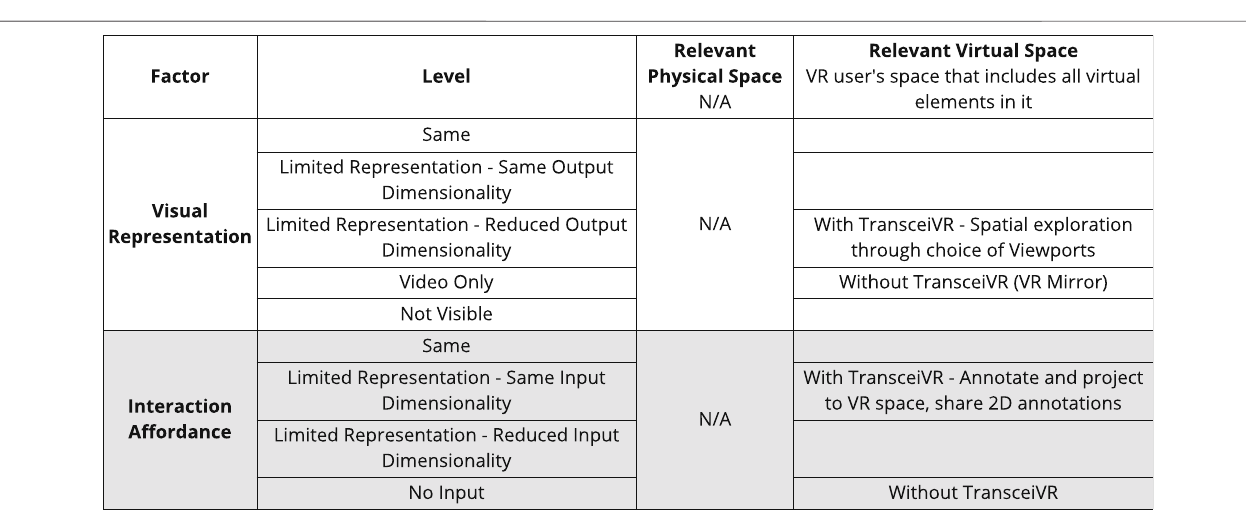
Frontiers in Virtual Reality |